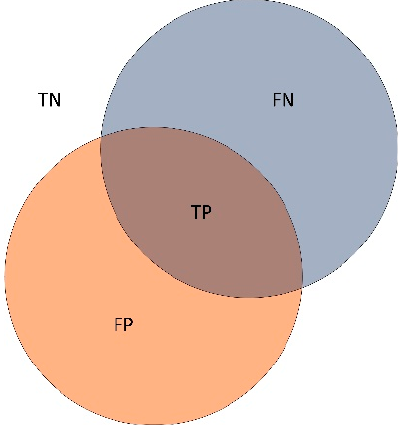
Figure 5. Class-IoU. TP: The number of Wheat correctly classified. FP: The number of classifier misclassifications. TN: The number of non-Wheat correctly classified. FN: The number of classifiers missed.